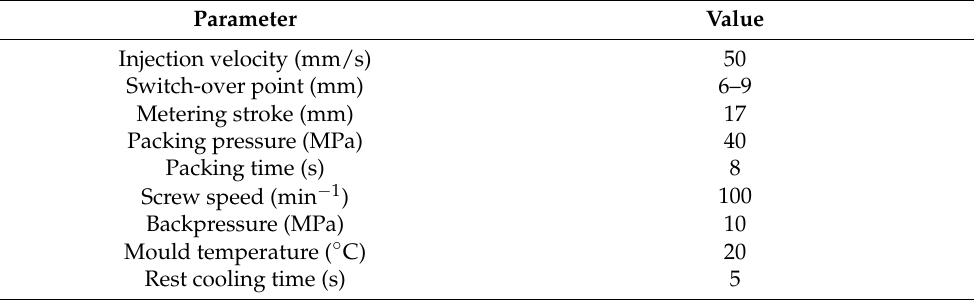
Table 3. Injection moulding parameters used for the preparation of the test